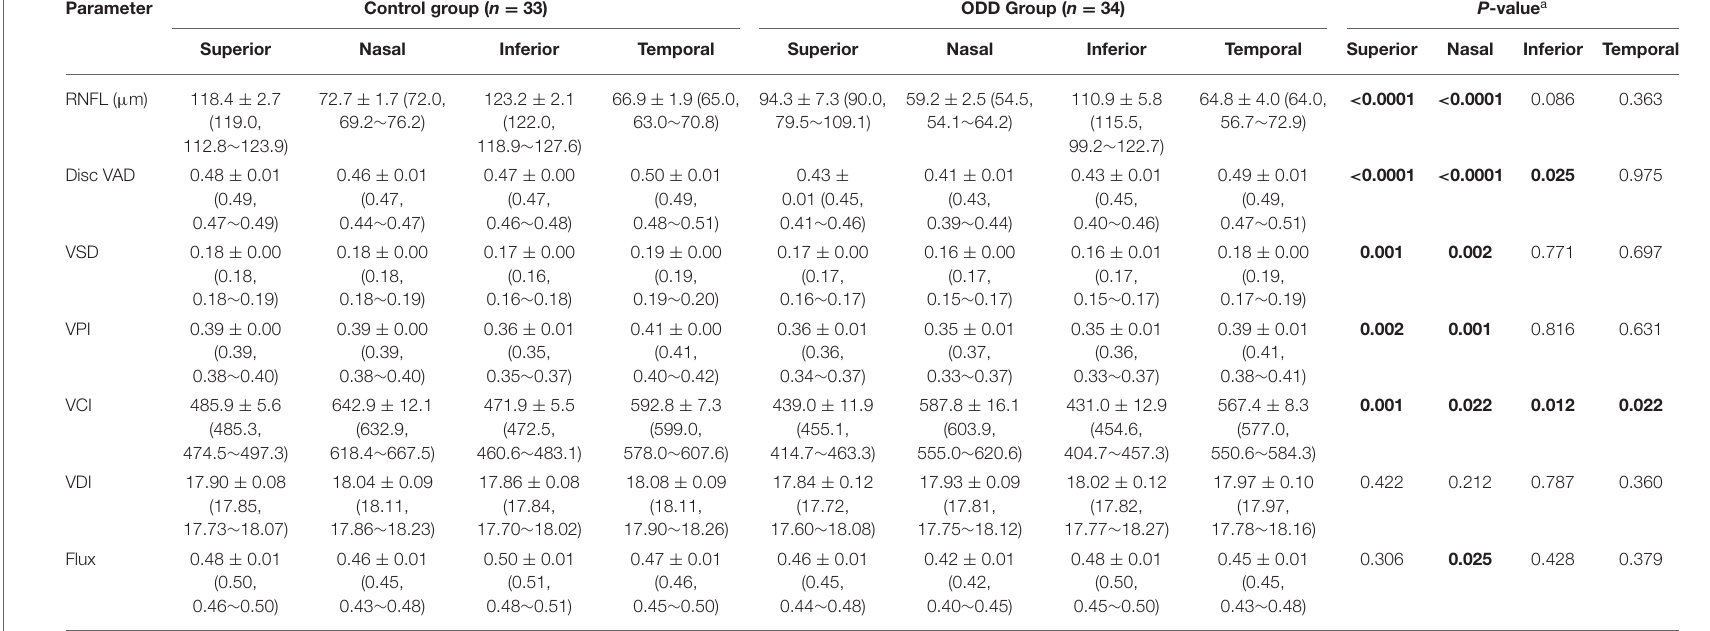
TABLE 2 | Differences in parapapillary OCT and OCTA parameters by quadrants between controls and eyes with optic disc drusen.